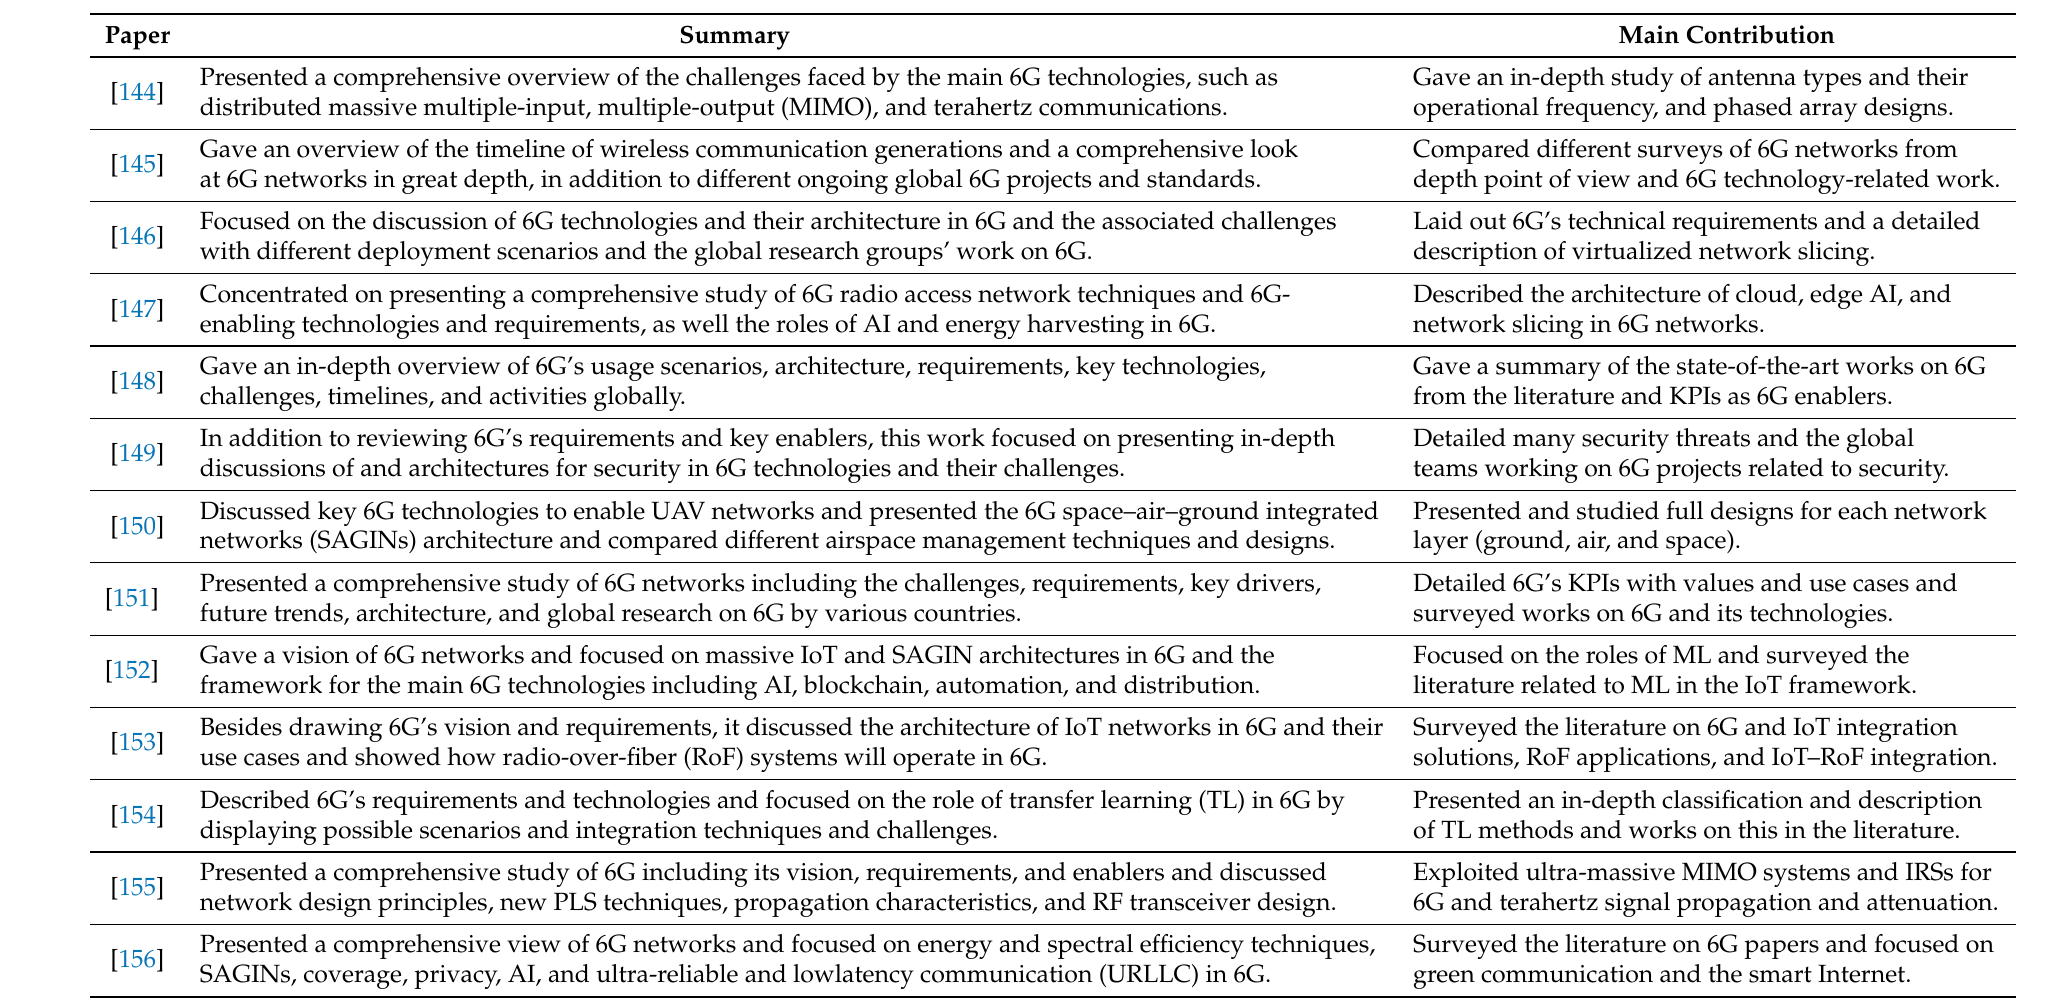
Table 4. A summary of papers surveying B5G/6G networks in the past